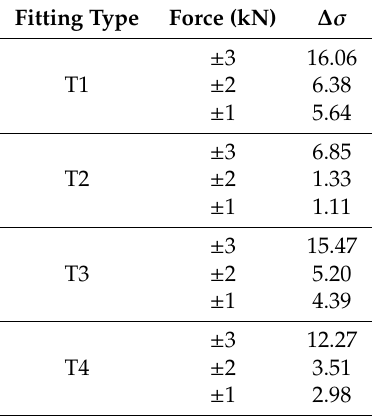
Table 13. Voltage variation values ∆ σ